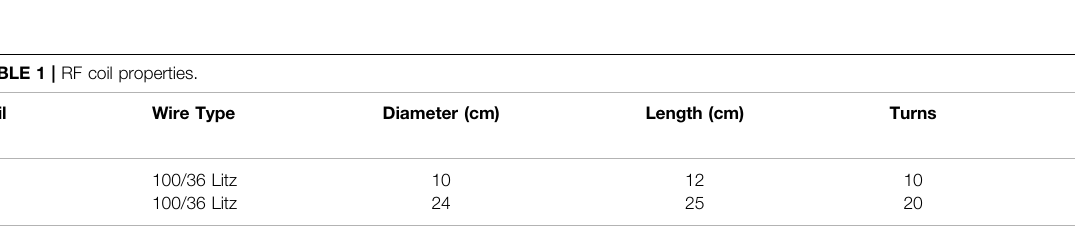
TABLE 1 | RF coil properties.